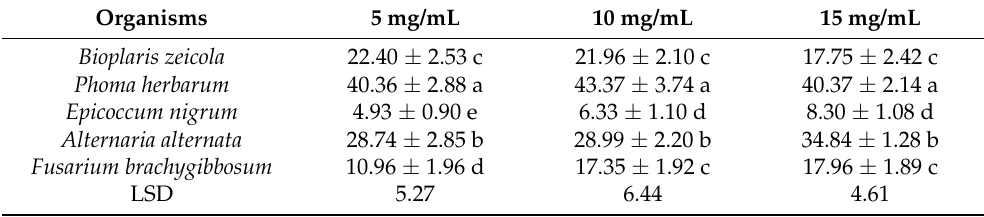
Table 3. Percentage inhibition of the pooled effect of nanoparticles on the fungi growth.